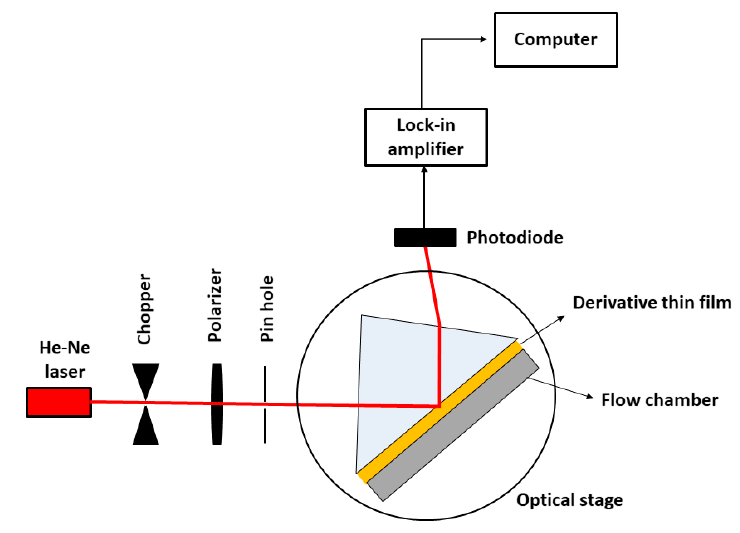
Figure 2. Illustration of the SPR setup system.